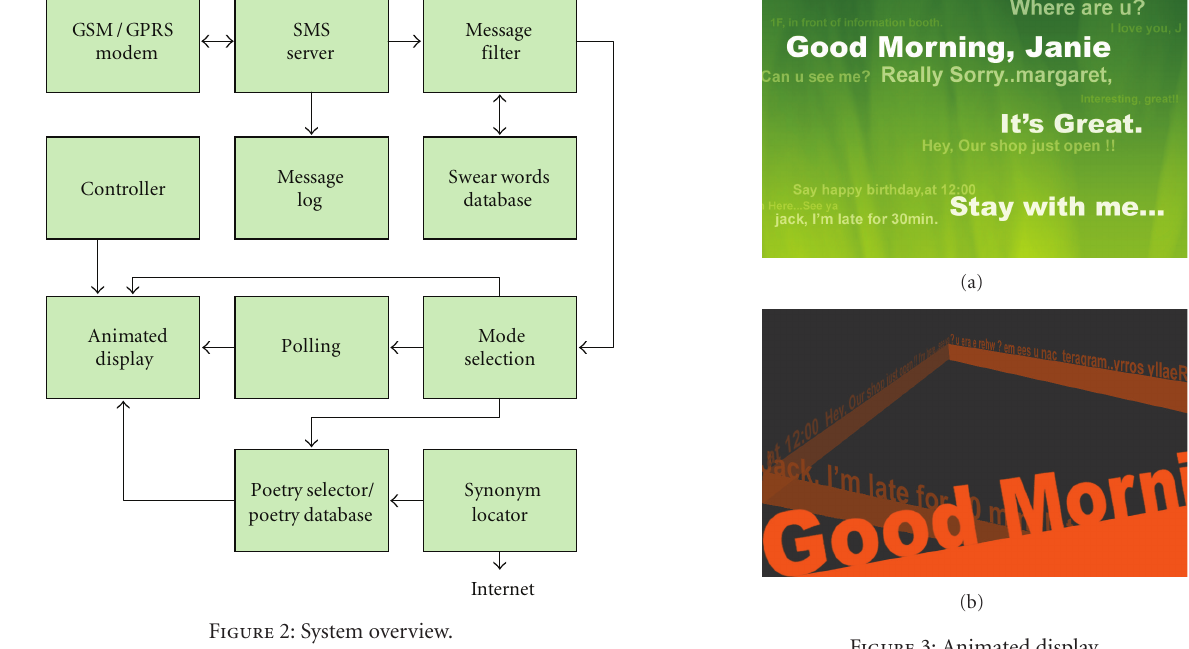
Figure 3: Animated